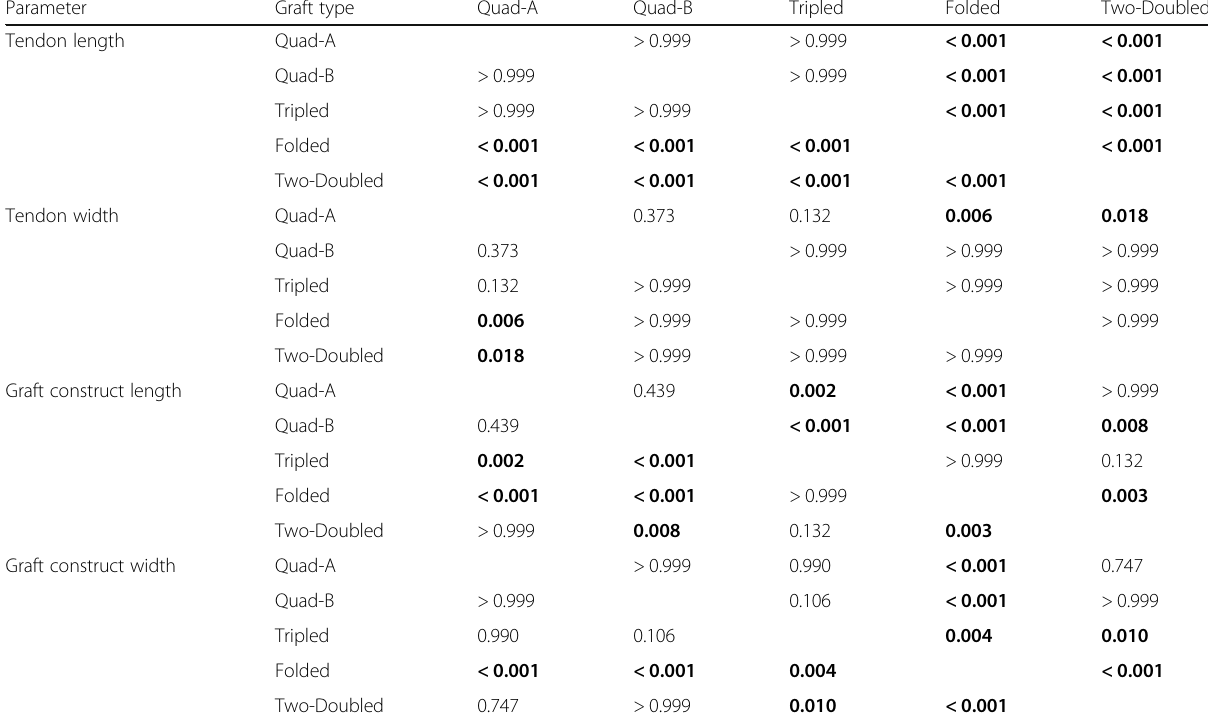
Table 2 Post hoc pairwise comparisons of tendon & graft construct dimensions Parameter